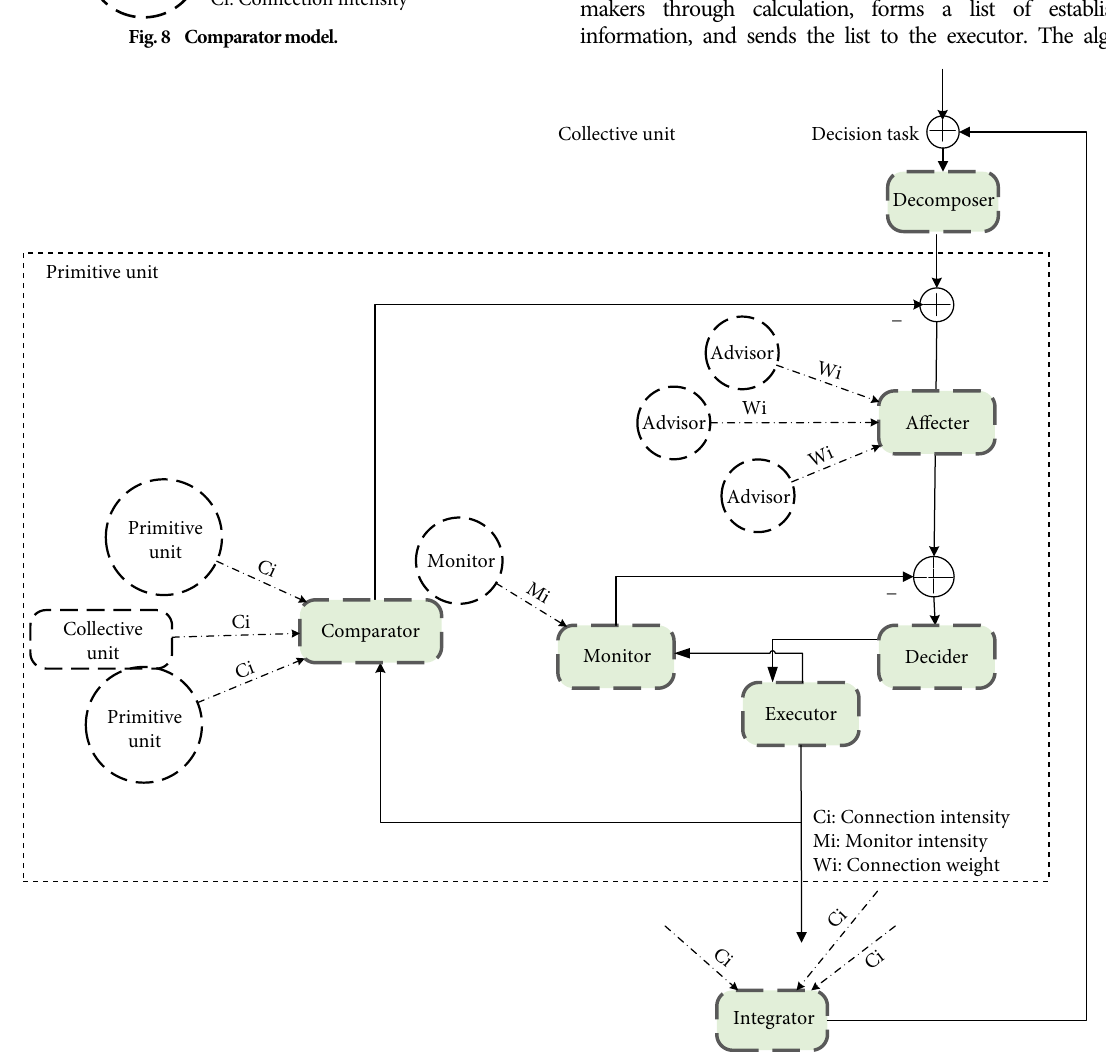
Fig. 9 Decomposer and integrator